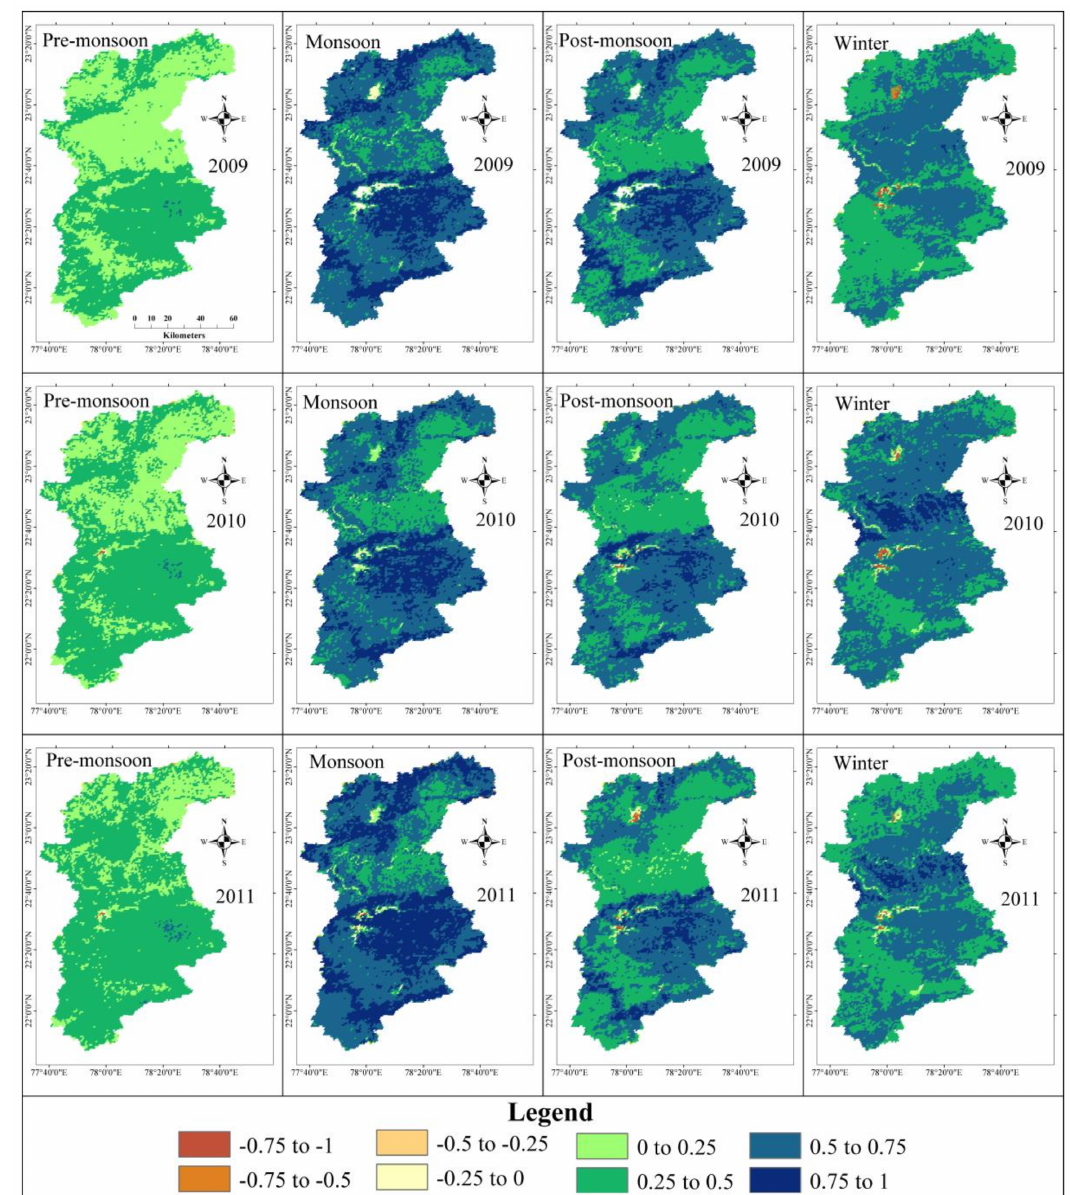
Figure 4. Seasonal normalized difference vegetation index (NDVI) for 2009, 2010, and